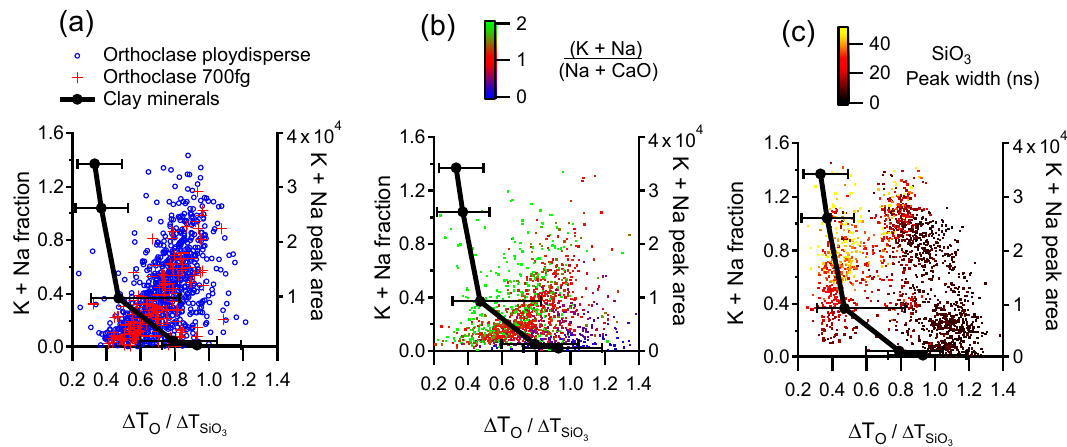
Figure 10. Peak shift ratio ( τ ) with respect to the combined sodium and potassium content. Clay mineral standards are the mode value of τ against the cation content in the structural formula derived from elemental analysis of the bulk samples. Error bars are the 25 and 75 percentiles. Feldspar and illite NX cation content is measured from the positive ion mass spectral peak areas. (a) Polydisperse and mass selected 700fg orthoclase feldspar particles and (b) plagioclase feldspar with the CaO content ( m/z 56) highlighted. (c) The representative clay mineral sample illite NX with the width of the SiO 3 molecular ion highlighted in the colour function.